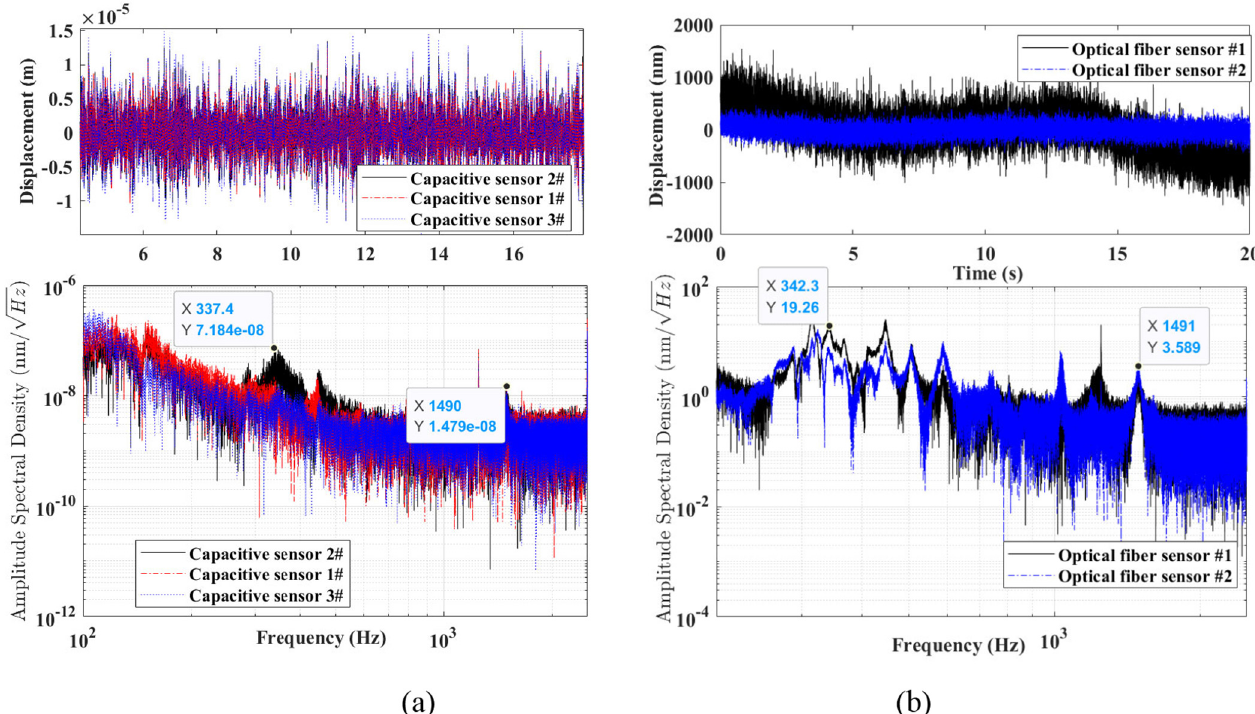
Fig. 11. Spectrogram of the signals: (a) capacitive sensors; (b) optical fi ber sensors.